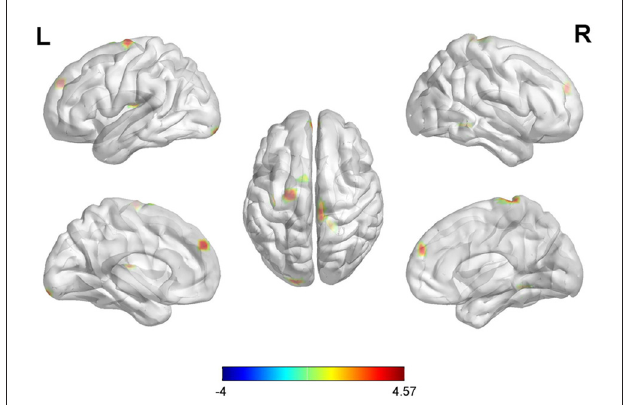
FIGURE 2 | Differences in left amygdala (AMYG.L) based functional connectivity (FC) between early postmenopausal women and controls (the peak level threshold was set at p = 0.001, small-volume correction (SVC)-corrected; FWE-corrected at p < 0.05). All the FC strengths were increased and marked in red.